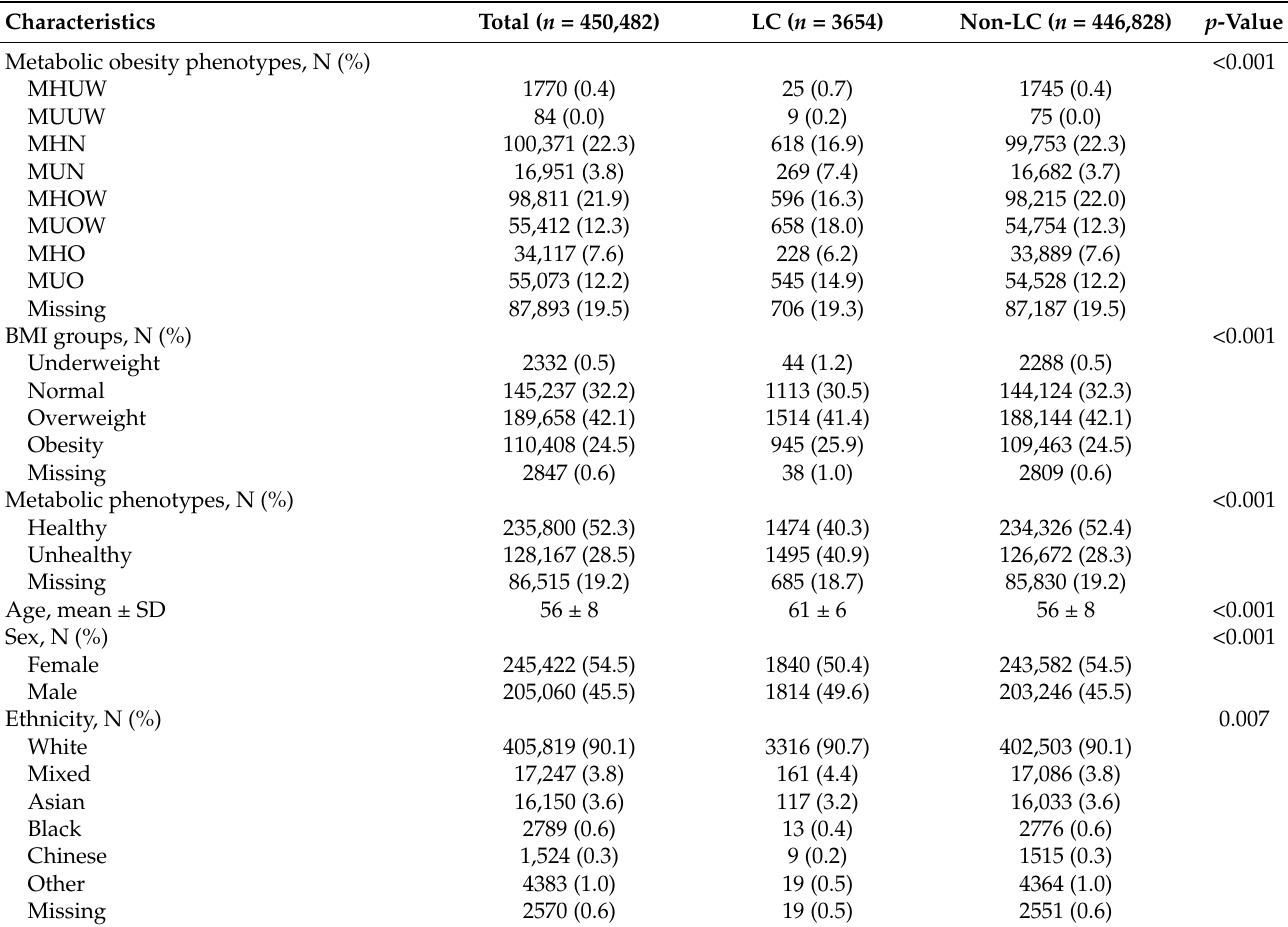
Table 1. Baseline characteristics of lung cancer cases and controls in the UK